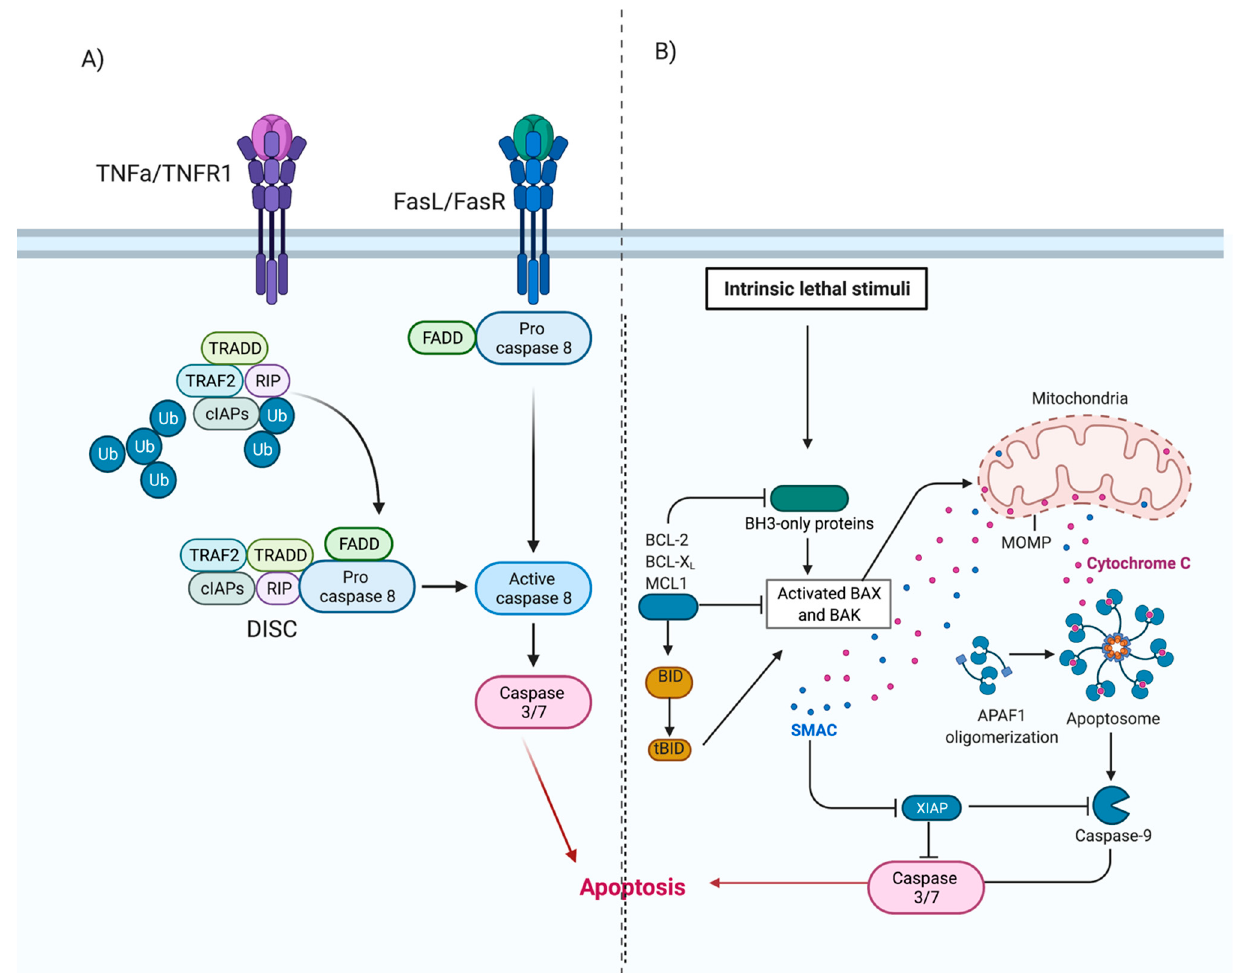
Figure 2. Extrinsic and Intrinsic apoptosis. ( A ) Extrinsic apoptosis. Ligand binding results in activation of cytoplasmic adapter proteins and recruitment of death domains on FasL/FasR or TNF- α /TNFR1. This activates FADD, which can directly activate pro-caspase-8 or can form a complex with TRADD and RIP, bind to TNF- α /TNFR1 and then induce auto- catalytic activation of procaspase-8. Activated caspase 8 initiates the execution phase of apoptosis. ( B ) Intrinsic apoptosis. Initiated by non-receptor-mediated stimuli that generate mitochondrial-initiated intracellular signals. These signals initiate a cascade of events resulting in the formation of an apoptosome. The apoptosome activates the executioner caspases-3/6/7 and initiates apoptosis. Adapted from [5,46,47]. Created with BioRender.com accessed on 12 December 2020.